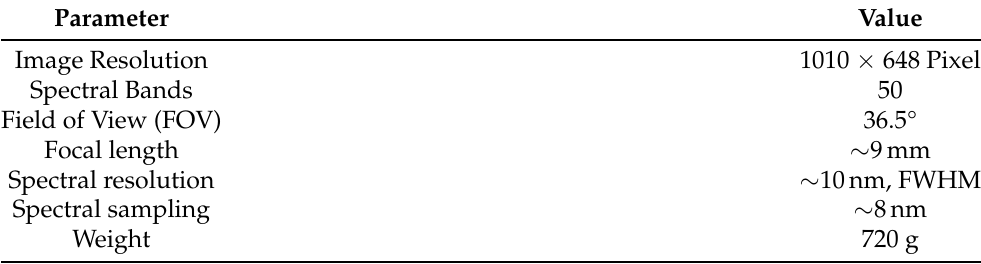
Table 1. Sensor specifications of the hyperspectral camera for the UAS survey.